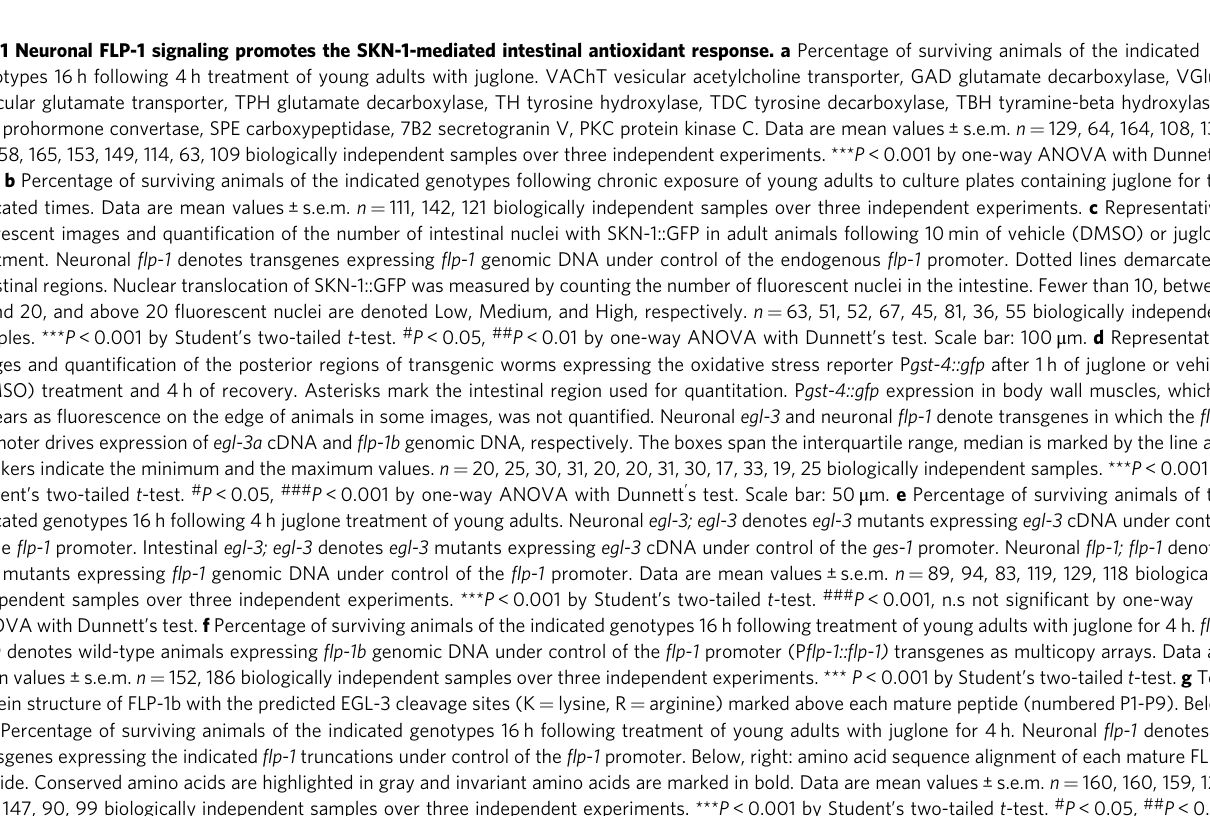
Fig. 1 Neuronal FLP-1 signaling promotes the SKN-1-mediated intestinal antioxidant response. a Percentage of surviving animals of the indicated genotypes 16 h following 4 h treatment of young adults with juglone. VAChT vesicular acetylcholine transporter, GAD glutamate decarboxylase, VGluT vesicular glutamate transporter, TPH glutamate decarboxylase, TH tyrosine hydroxylase, TDC tyrosine decarboxylase, TBH tyramine-beta hydroxylase, PC2 prohormone convertase, SPE carboxypeptidase, 7B2 secretogranin V, PKC protein kinase C. Data are mean values± s.e.m. n = 129, 64, 164, 108,